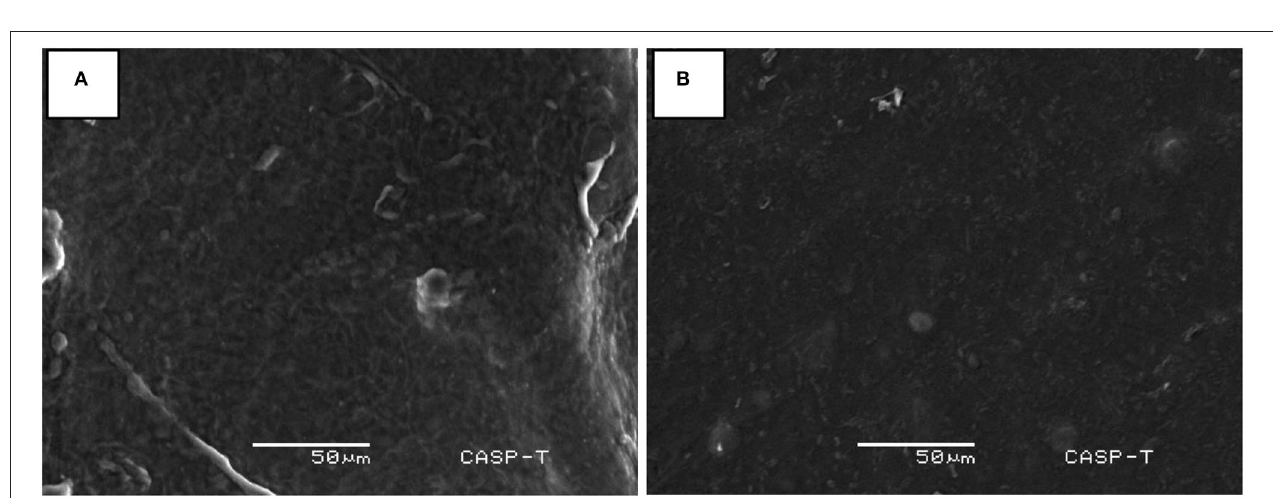
A crystalline structure of HgS deposited on the cell membrane of B. cereus AA-18 confirmed its ability to remediate mercury in contaminated wastewater as shown in Figure 3